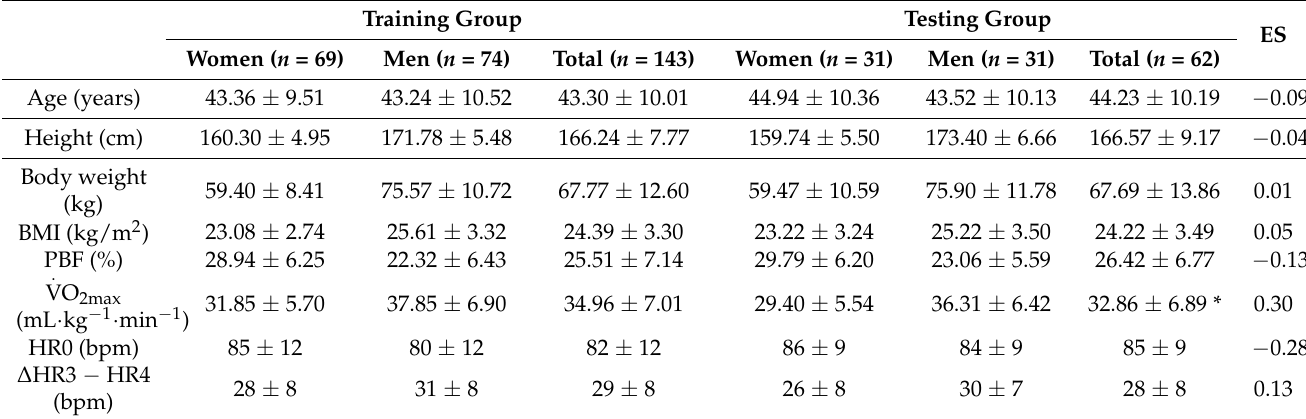
Table 1. Physical characteristics of the participants. Training Group